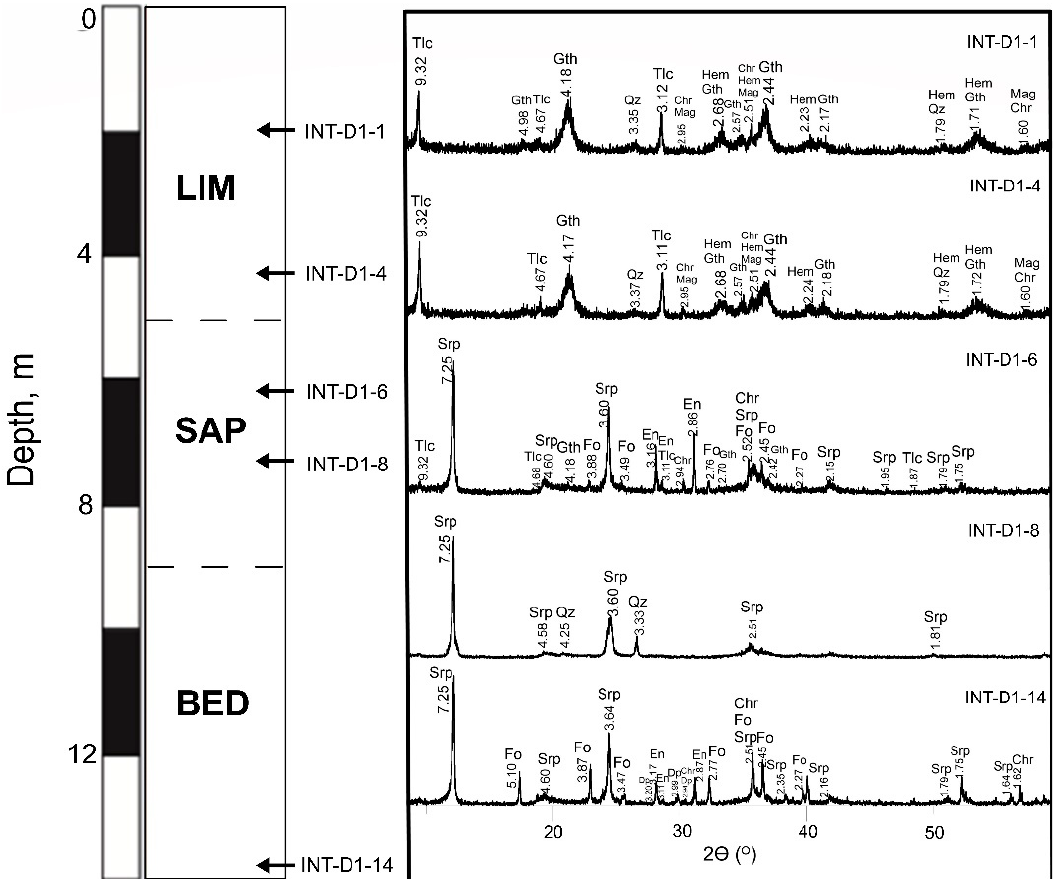
Figure 4. Stacked XRPD patterns of bedrock, saprolite, and limonite representative samples from BB2515 drill core. Fo—forsterite, En—enstatite, Srp—serpentine, Tlc—talc, Qz—quartz, Chr—chromite, Mag—magnetite, Gth—goethite, Hem—hematite.